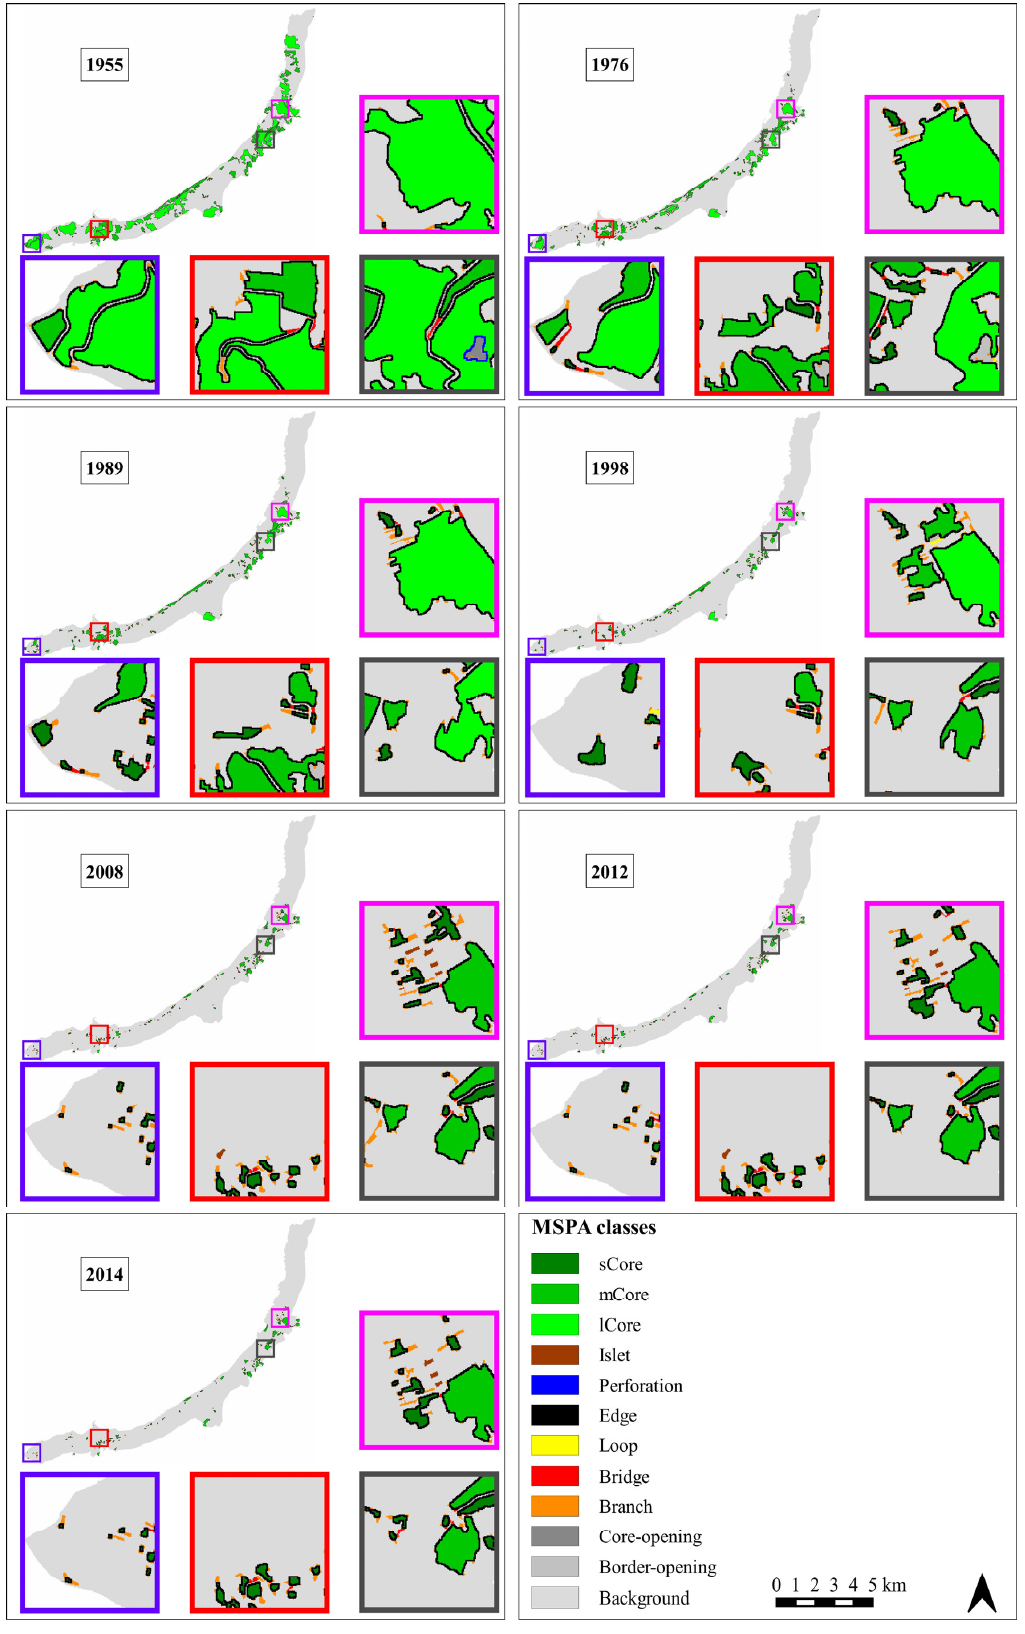
Figure 4. Spatial configuration of morphological spatial pattern classes for each of the years investi- gated in the time interval